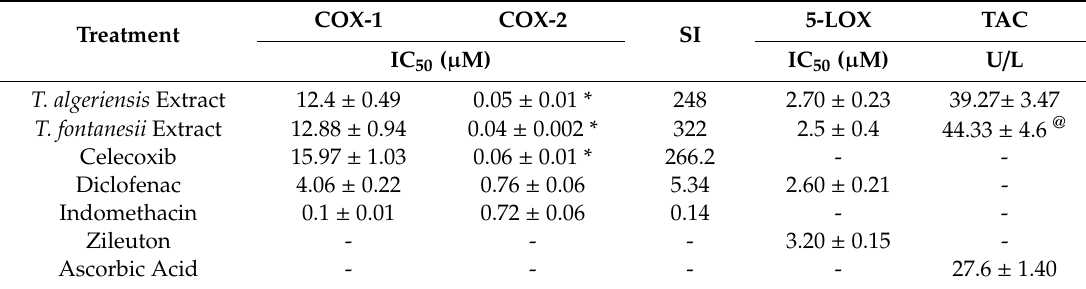
Table 2. In vitro cyclooxygenase (COX-1 and COX-2) and lipoxygenase (5-LOX) inhibition (IC 50 ) and the total antioxidant capacity (U/L) of T. algeriensis and T. fontanesii extracts. Treatment